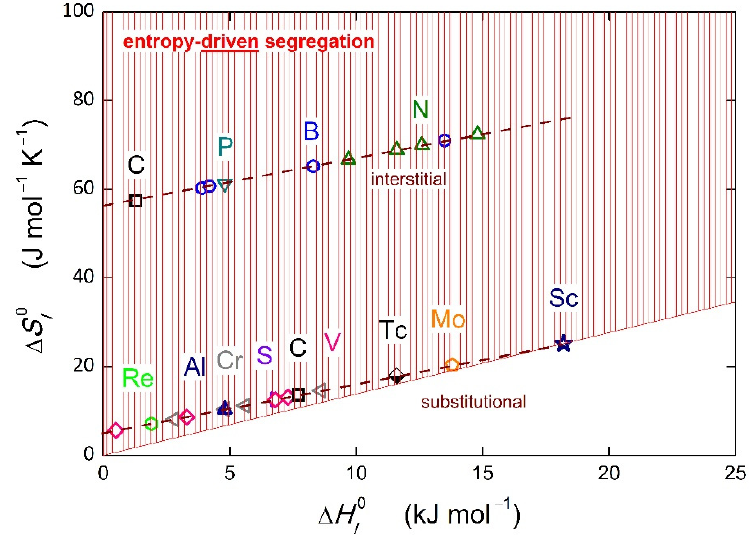
Figure 2. Details of the plot in Figure 1 with candidates to exhibit the entropy-driven grain boundary segregation in iron-based systems for T > 723 K. The dashed lines represent extrapolations of individual branches of the enthalpy–entropy compensation effect. Data from Table 1.